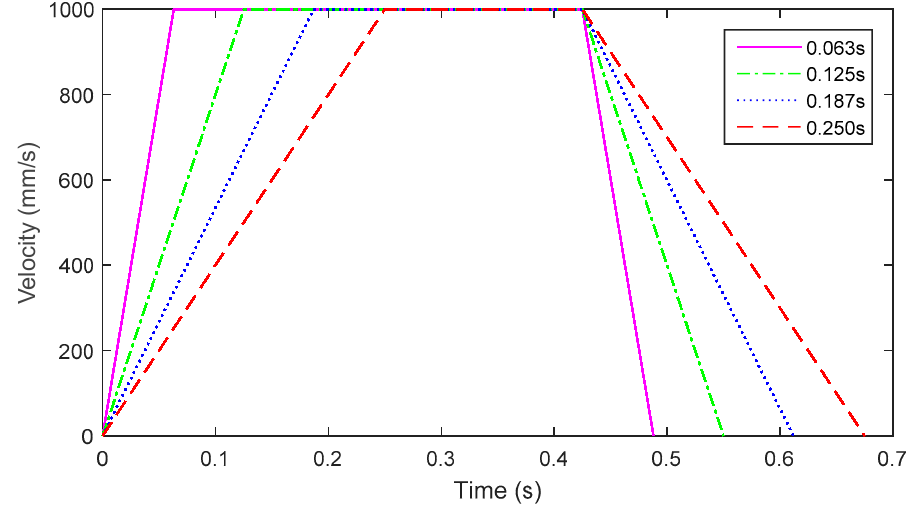
Figure 17. The velocity profiles when moving 425 mm with a maximum velocity of 1000 mm/s.